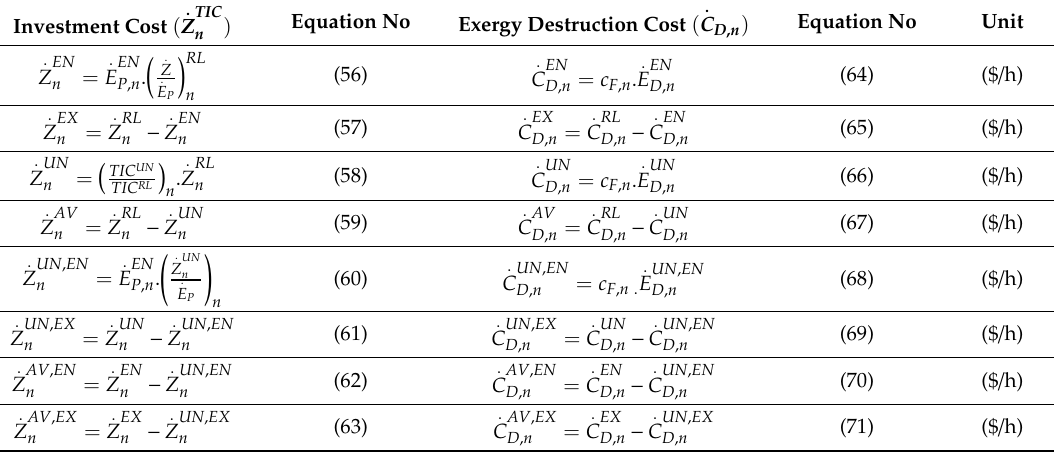
Figure 4. A schematic subdivision respecting the costs of investment and exergy destruction. . . TIC C D , n and the Z The equations respecting the are derived and demonstrated in Table 9. Table 9. Advanced exergoeconomic equations of investment and exergy destruction costs [55].